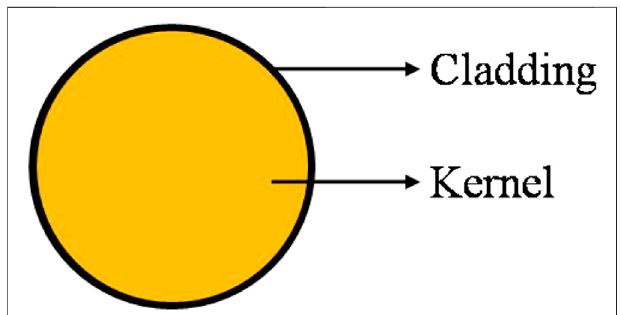
FIGURE 5 | YH 1.8 solid moderator pin.